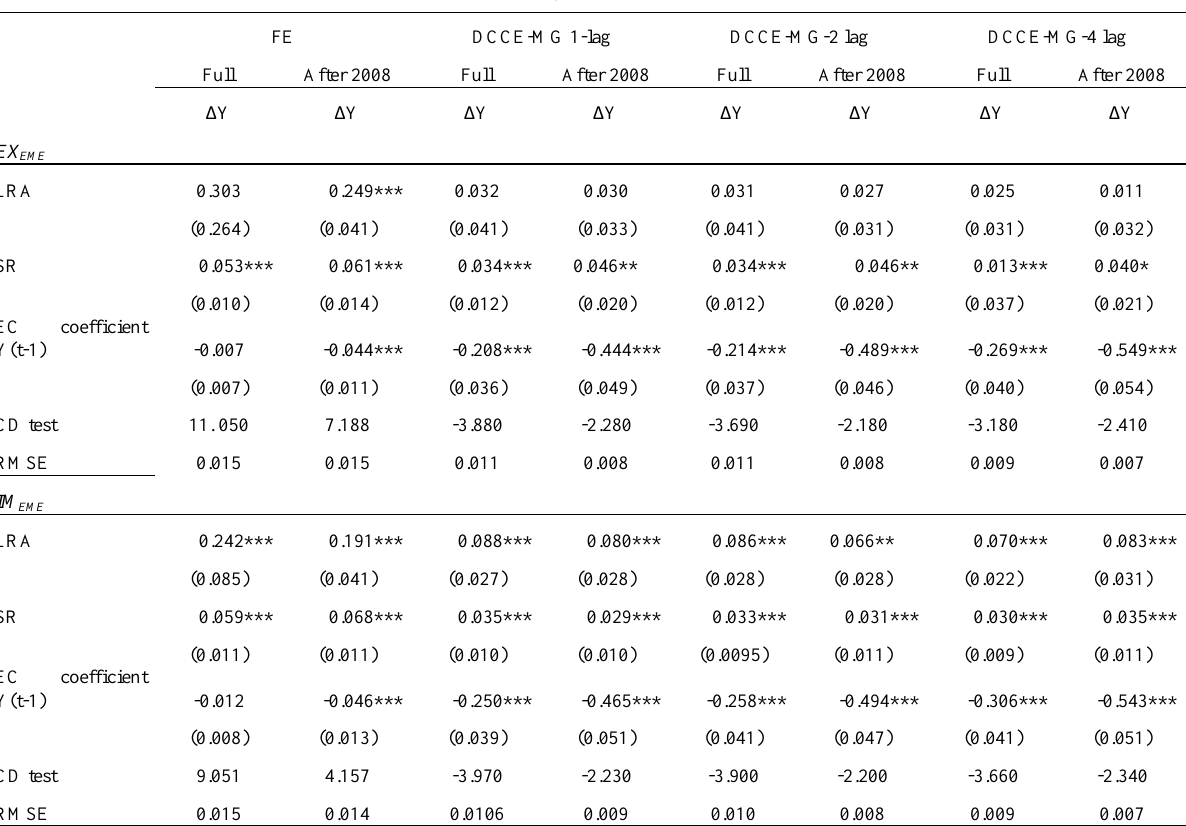
Table 7b : Dynamic models with the independent variables export and import to emerging economies except to China FE DCCE-MG 1-lag DCCE-MG-2